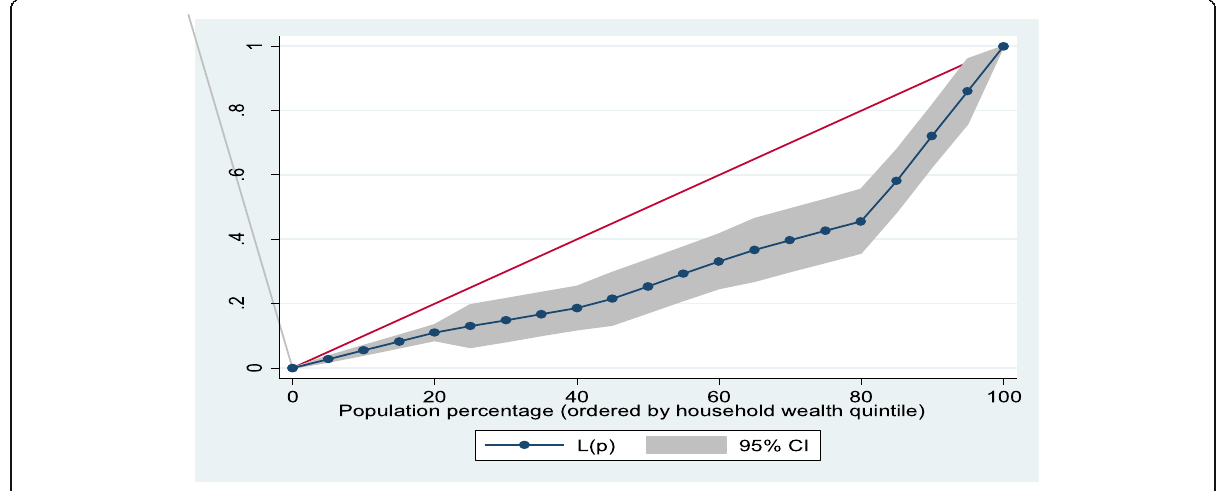
Fig. 3 Overall household wealth-related inequalities of ≥ 8 ANC contacts